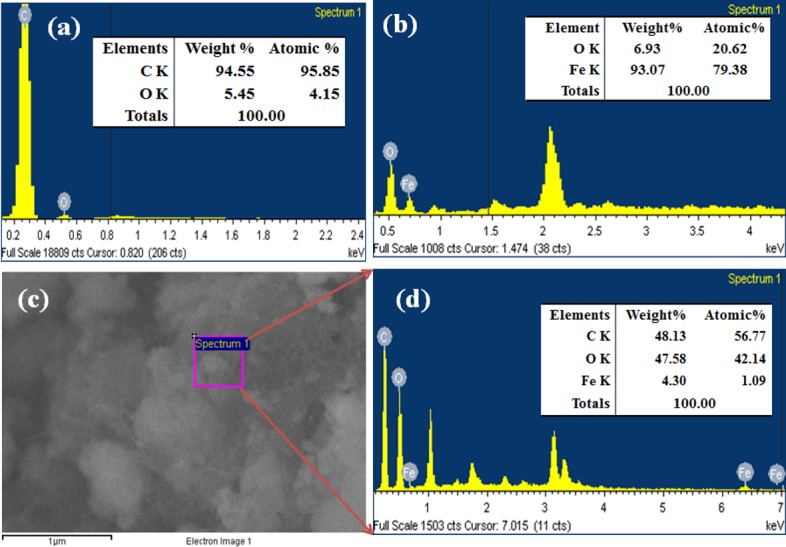
Elemental analysis (a) CNT, (b) Fe3O4 NPs, and (c-d) Fe3O4.CNT NCs.